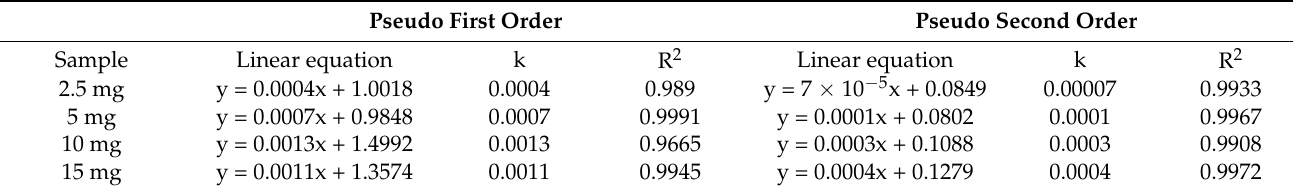
Table 1. Kinetic equation of CIP by using (3%)Ag-TiO 2 /rGO/HNT.